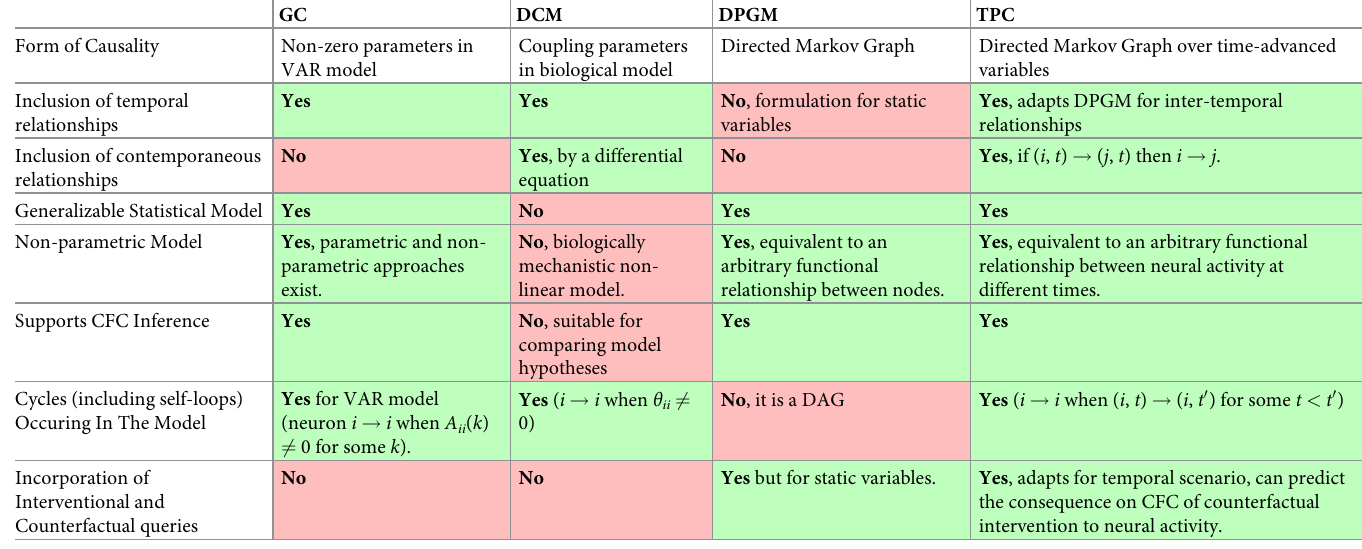
Table 2. Comparative summary of different approaches for causal modeling. GC DCM TPC Form of Causality Non-zero parameters in Coupling parameters VAR model in biological